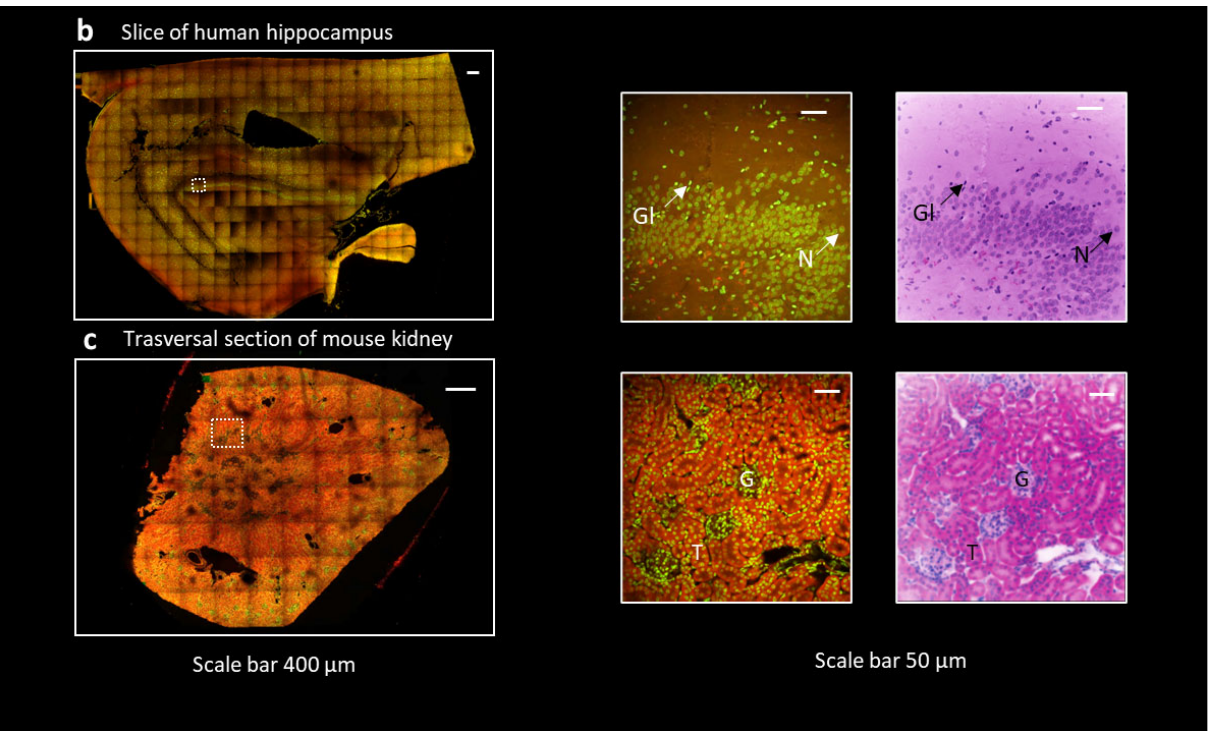
Figure 3. Reconstruction of tissue sections using the combination of SWITCH clearing protocol and TPFM. All sections in the figure are stained with Eosin and DAPI. Next, and under all images of the entire section, a zoom ‐ in on a particular region of interest (ROI) is represented with traditional H&E fluorescent staining and pseudo ‐ coloration. The following sections are: ( a ) A segment of mouse small intestine, scale 400 µ m, ROI, scale bar 40 µ m; E—columnar epithelium; GC—goblet cells. ( b ) A slice of human hippocampus, scale 400 µ m, ROI, scale bar 40 µ m. N—Neuron; Gl—Glial cell. ( c ) A transversal section of mouse kidney, scale 400 µ m, ROI, scale bar 40 µ m; G—Glomerulus;